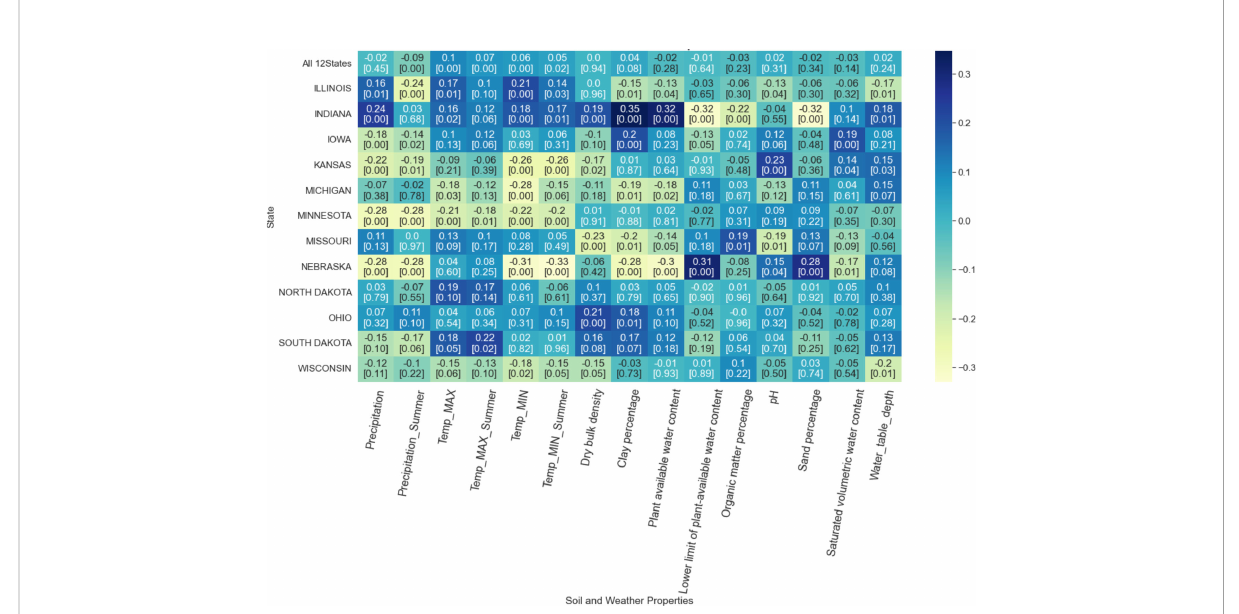
FIGURE 7 Correlation between soil-weather properties and RMSE. The darker the color, the higher the linear correlation between the RMSE of the model and the feature along the x-axis. The fi rst row provides the overall correlation for all 12 states with the feature along the x-axis. The remaining rows demonstrate the correlation at the state level. The fi rst value in each box represents the correlation value, and the second value corresponds to the associated